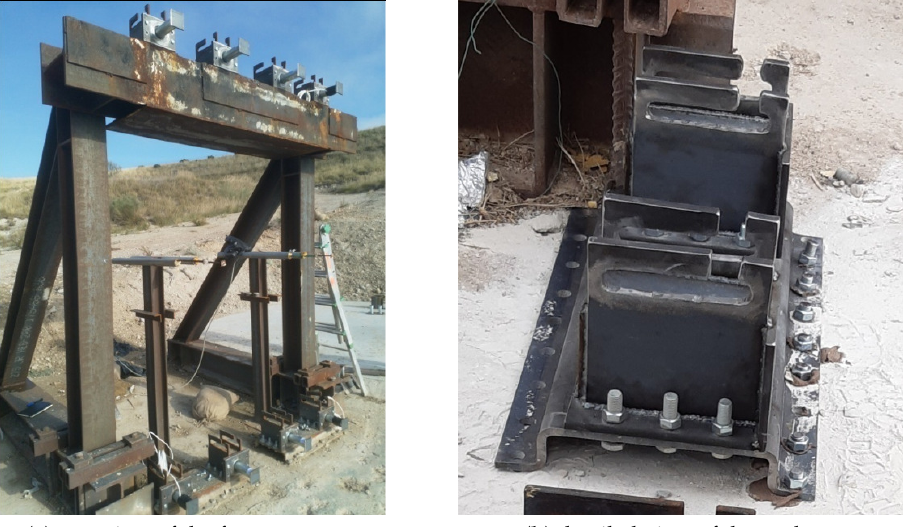
Figure 14. Rigid anchors for bottom